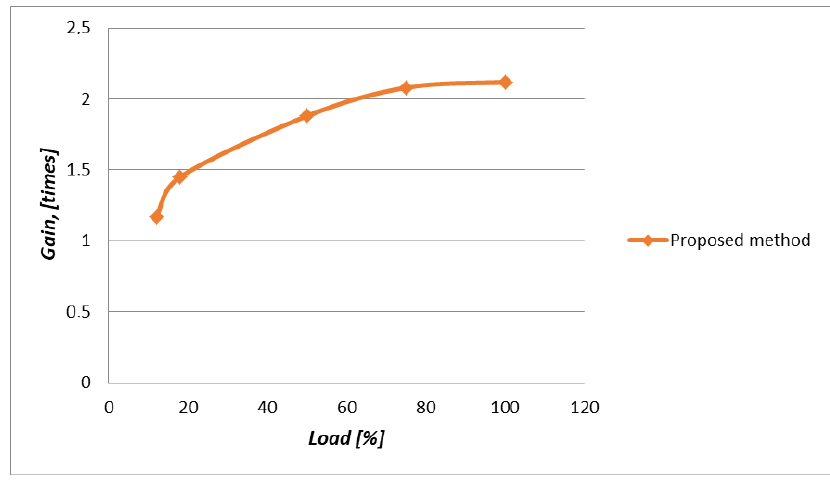
Figure 27. Efficiency of the proposed method at different loads. Figure 27. E ffi ciency of the proposed method at di ff erent